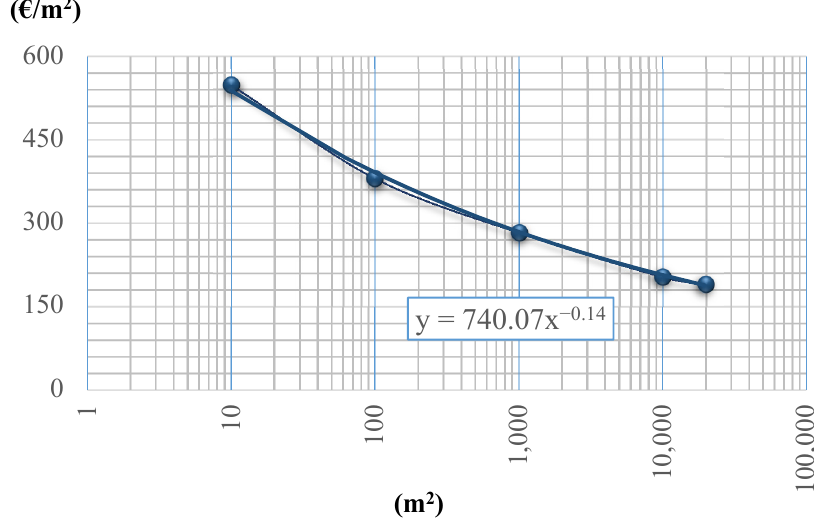
Figure 1. Installation costs per m 2 of different sizes of solar heat energy plants, including heat storage [21].